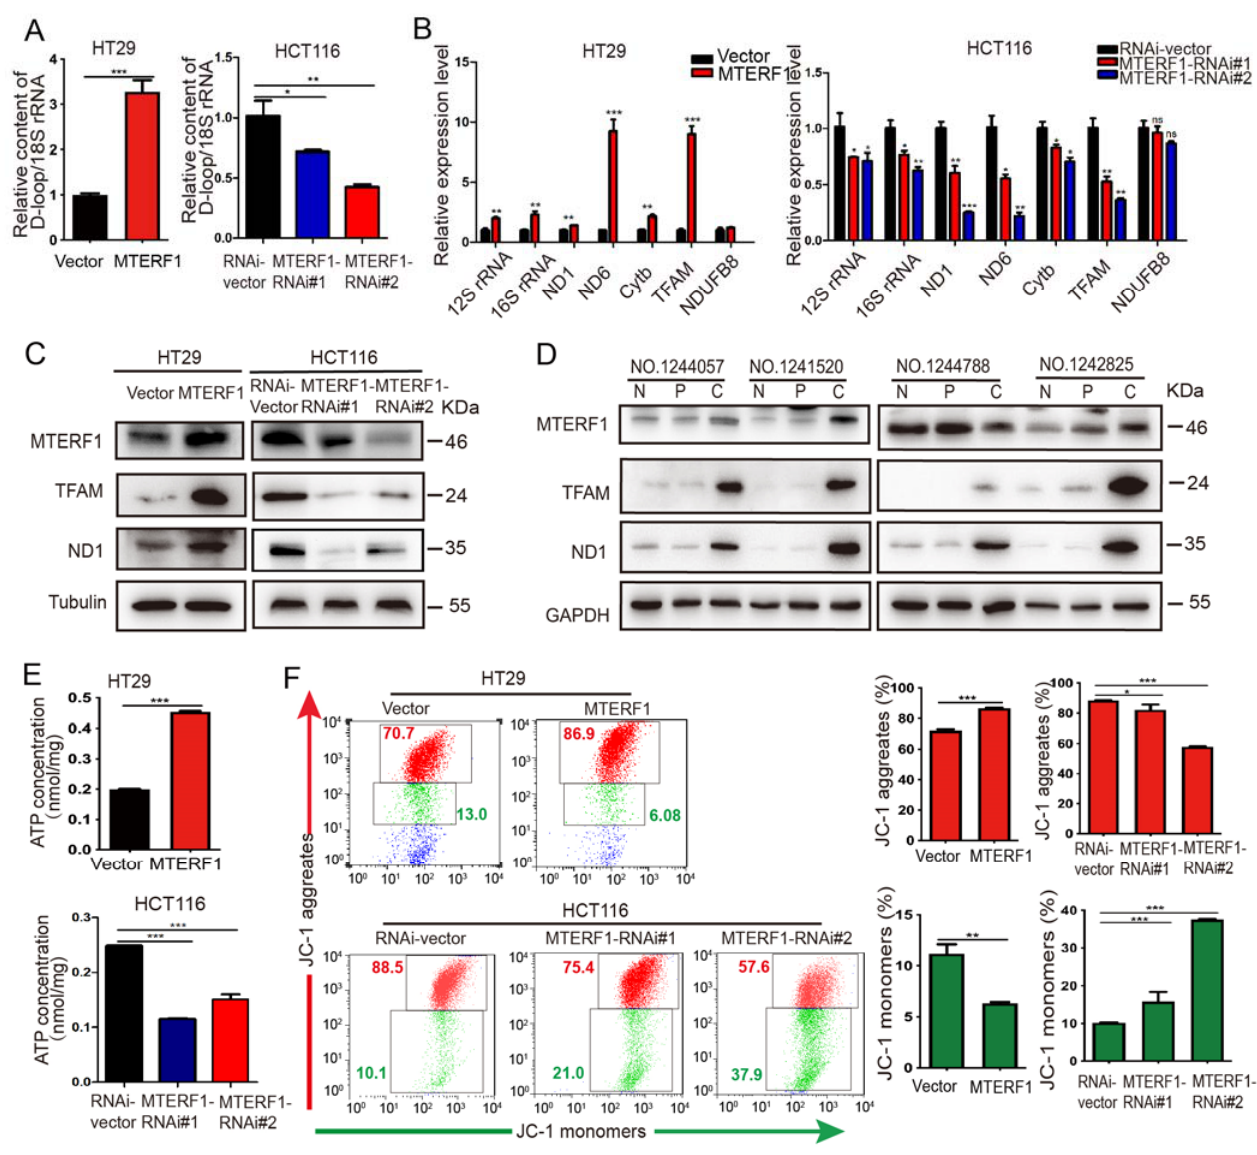
Figure 4. MTERF1 regulates mitochondrial gene expression and OXPHOS in CRC cells. ( A ) Detection of the relative content of D-loop/18S rDNA by qPCR in HT-29 and HCT116 cells upon upregulation and downregulation of MTERF1. ( B , C ) qRT–PCR analysis ( B ) and Western blot analysis ( C ) of